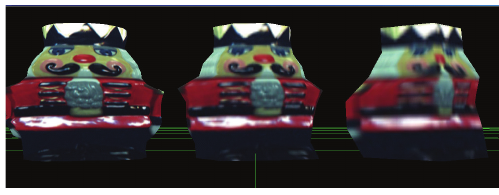
Figure 2: Evaluation